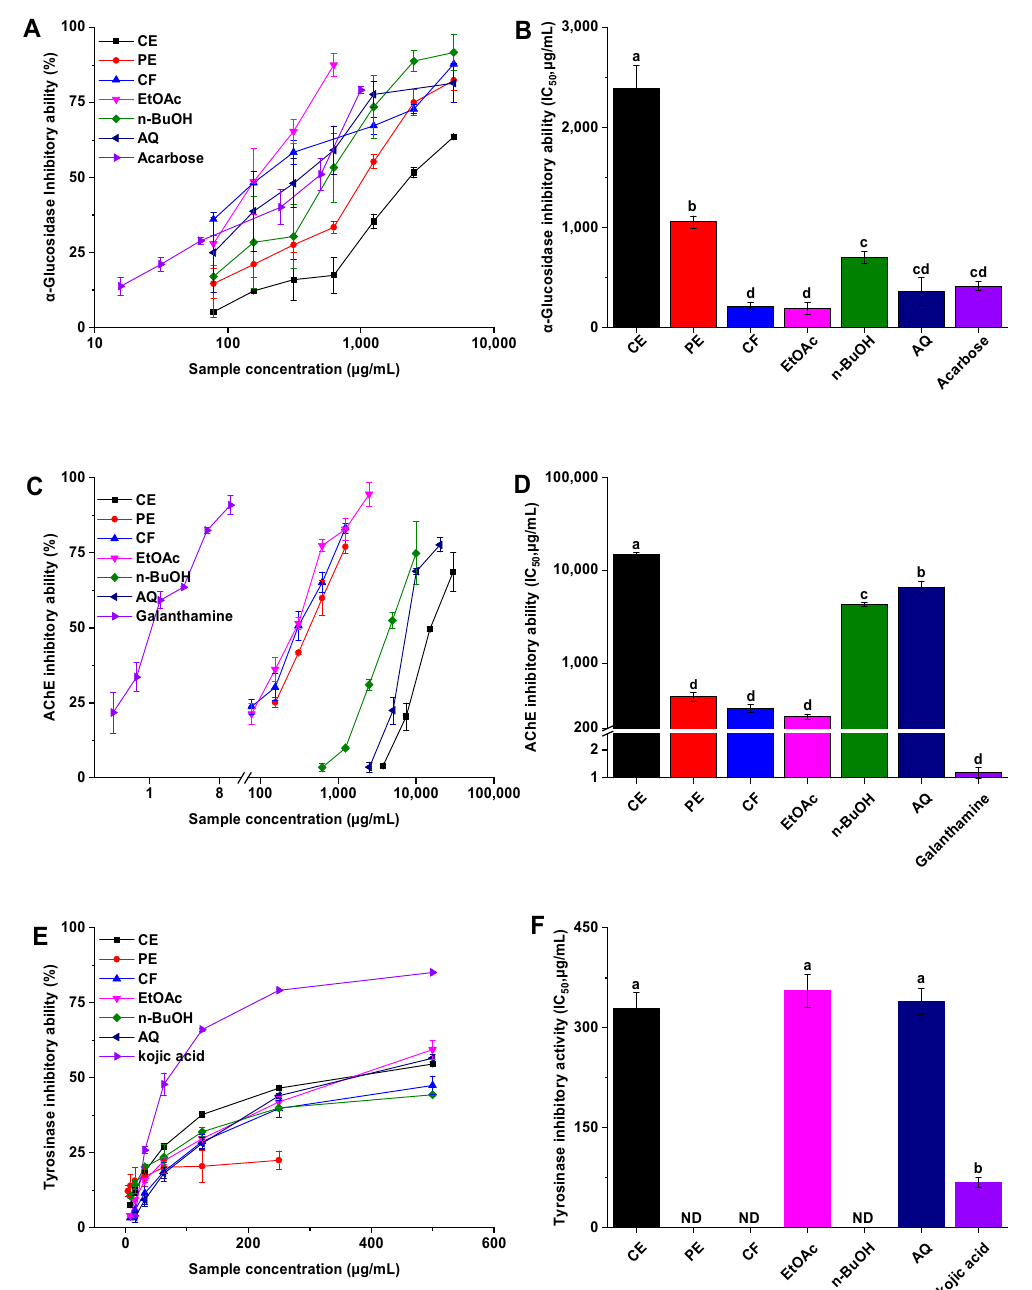
Glucosidase = the IC 50 value for α -glucosidase inhibitory; AChE = the IC 50 value for acetylcholinesterase inhibitory activity; Tyrosinase = the IC 50 value for tyrosinase inhibitory; HepG2 = the IC 50 value for inhibition on HepG2 cell proliferation; MCF-7 = the IC 50 value for inhibition on MCF-7 cell proliferation.